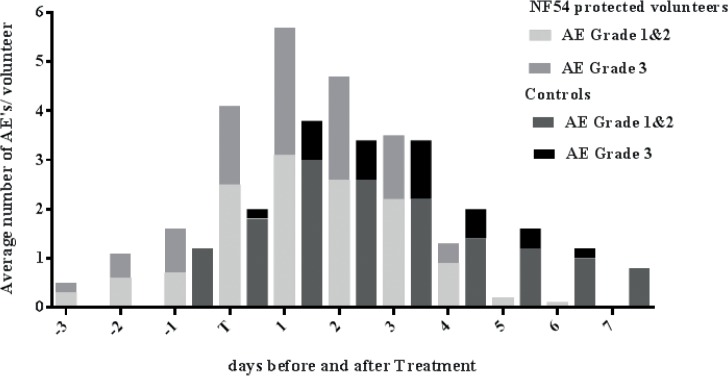
Adverse events before and after initiation of treatment.Average number of possibly and probably related (both solicited and unsolicited) AE per previously NF54 protected or control volunteer in relation to the time of positive thick smear (day of treatment). Time points are plotted towards day of treatment, depicted as ‘T’, from 3 days before until 7 days after start of treatment.